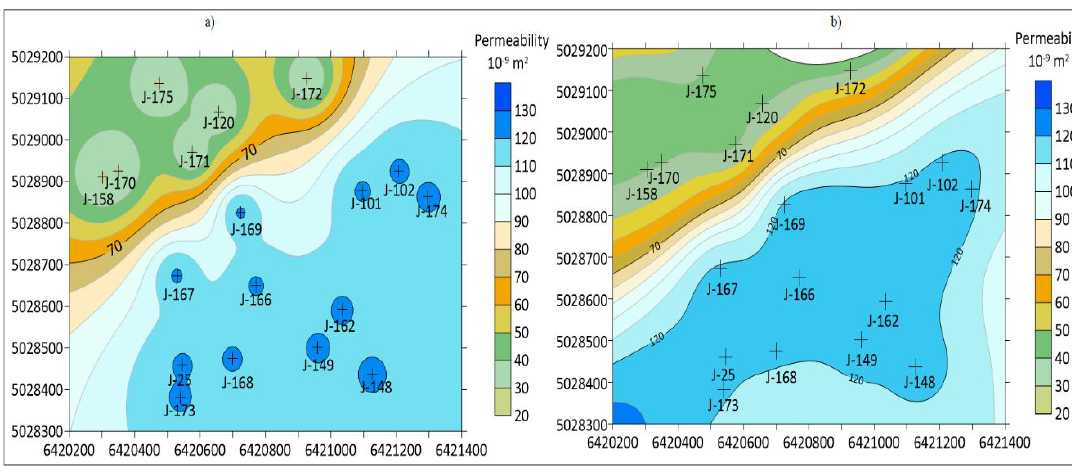
Figure 9. Permeability of reservoir "K": ( a ) IDW; ( b ) MSM.